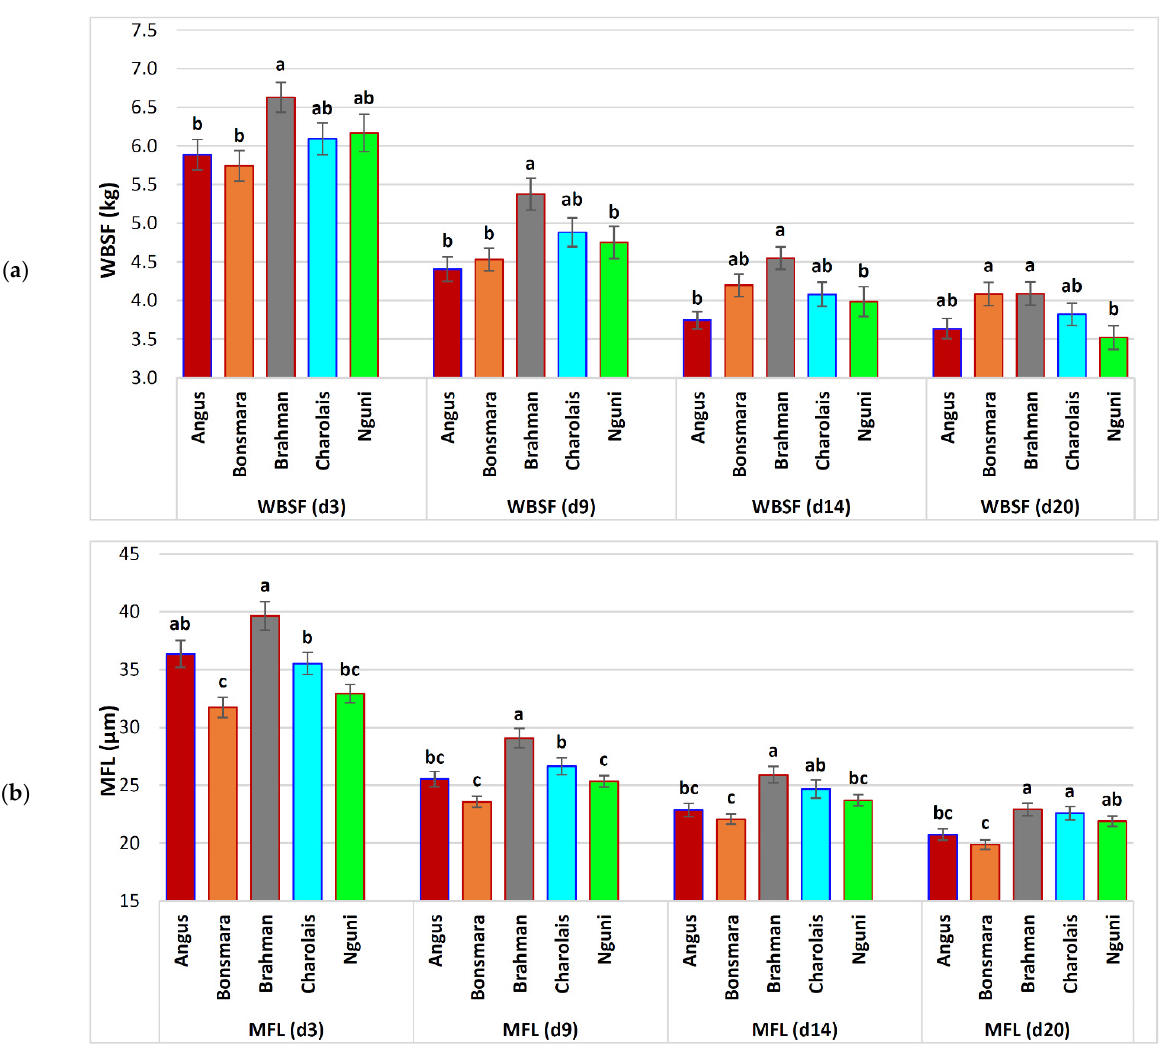
Figure 1. Changes in tenderness in five South African beef breeds over an ageing period of 20 days. Least squares means (LSM) that were statistically significantly different within ageing periods ( p ≤ 0.05) are indicated with different ascending letter superscripts (a, b, c). Error bars represent the standard errors of these LSM: ( a ) WBSF—Warner–Bratzler shear force; ( b ) MFL—myofibril fragment length.